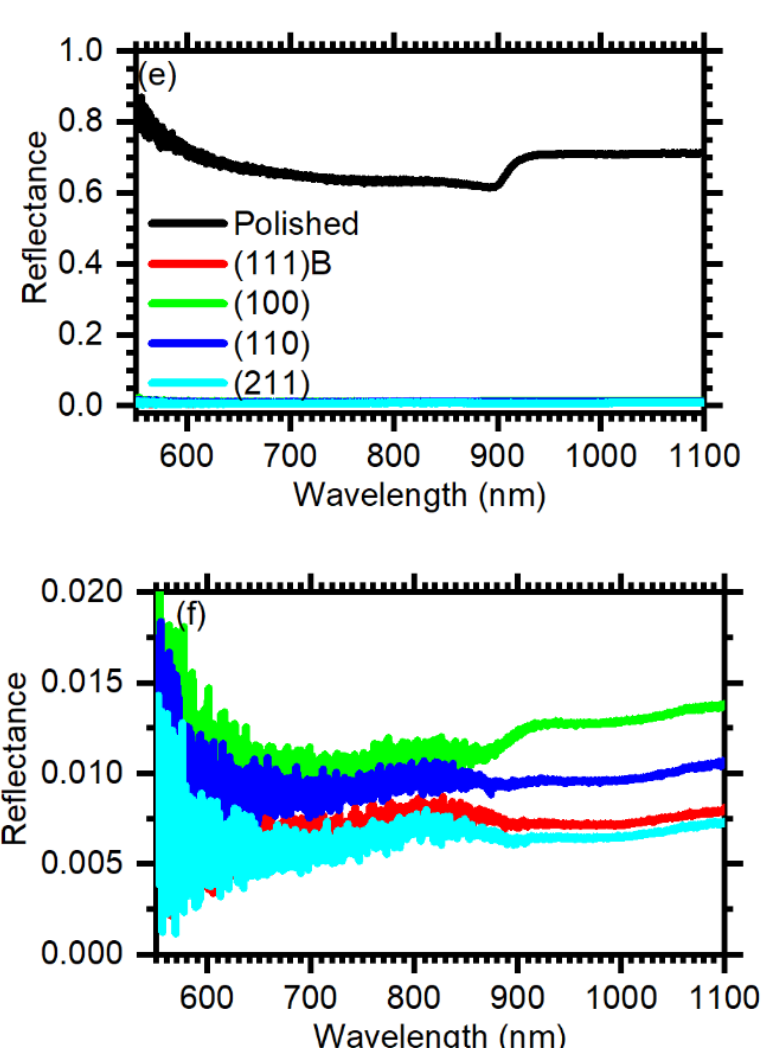
Figure 3. Cross-sectional ( a – d ) and tilted view ( a’ – d’ ) SEM micrographs of the (100) ( a , a’ ), (110) ( b , b’ ), (111)B ( c , c’ ), and (211) ( d , d’ ) GaAs crystalline planes. ( e ) Normal incidence reflectance spectra of polished (black) and etched GaAs surfaces: (100), red; (110), green; (111)B, blue; (211), cyan. ( f ) Reflectance spectra of the etched samples: A magnification of the reflectance scale allows to appreciate the spectral